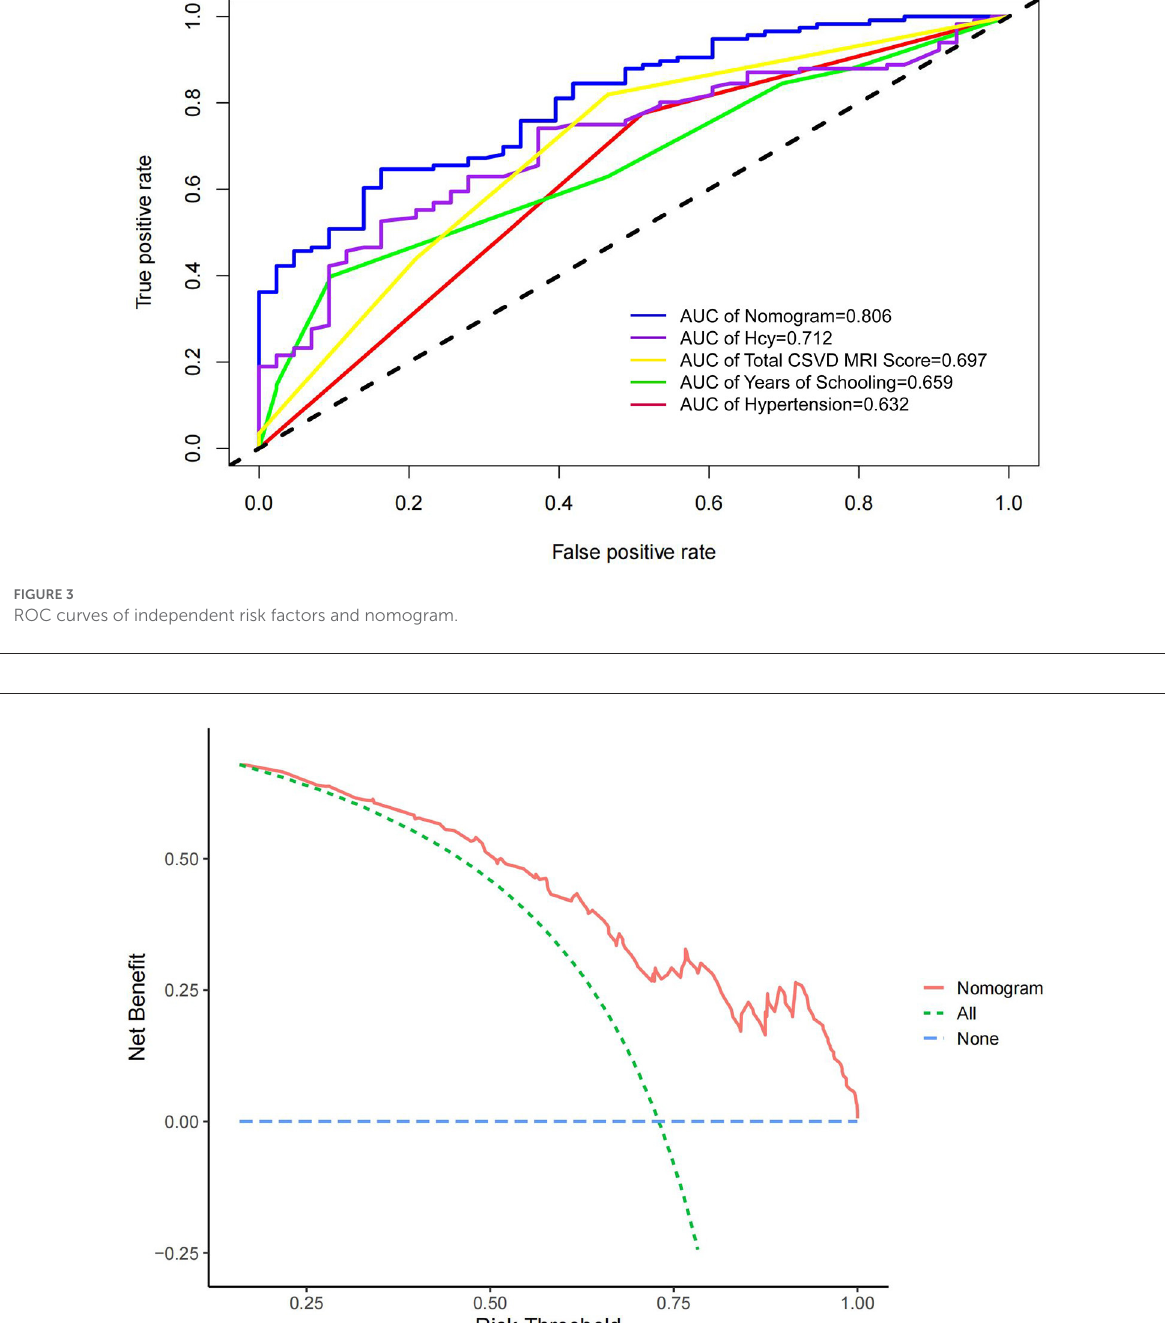
inflammation, and endoplasmic reticulum (ER) stress cause neurovascular dysfunction (34), which in turn puts CSVD patients at increased risk of cognitive